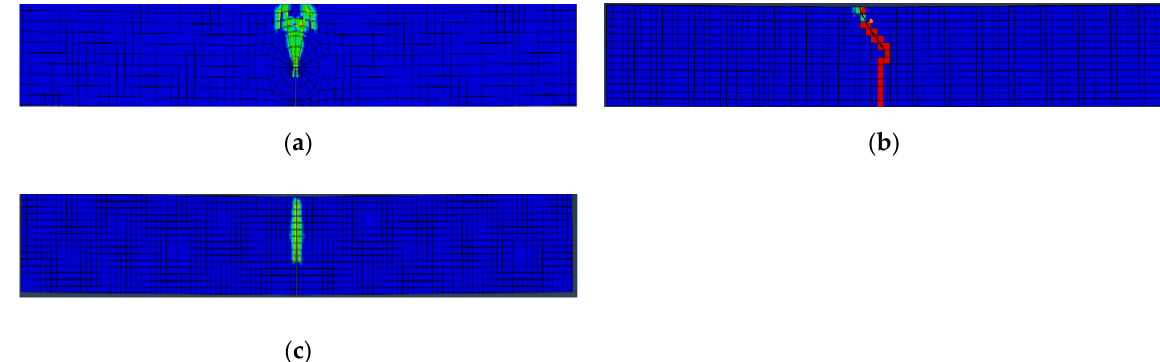
Figure 4. Concrete damage initiation and propagation paths; ( a ) tensile damage for contour integral technique (CIT) model; ( b ) extended finite element method (XFEM) model; ( c ) VCCT model.